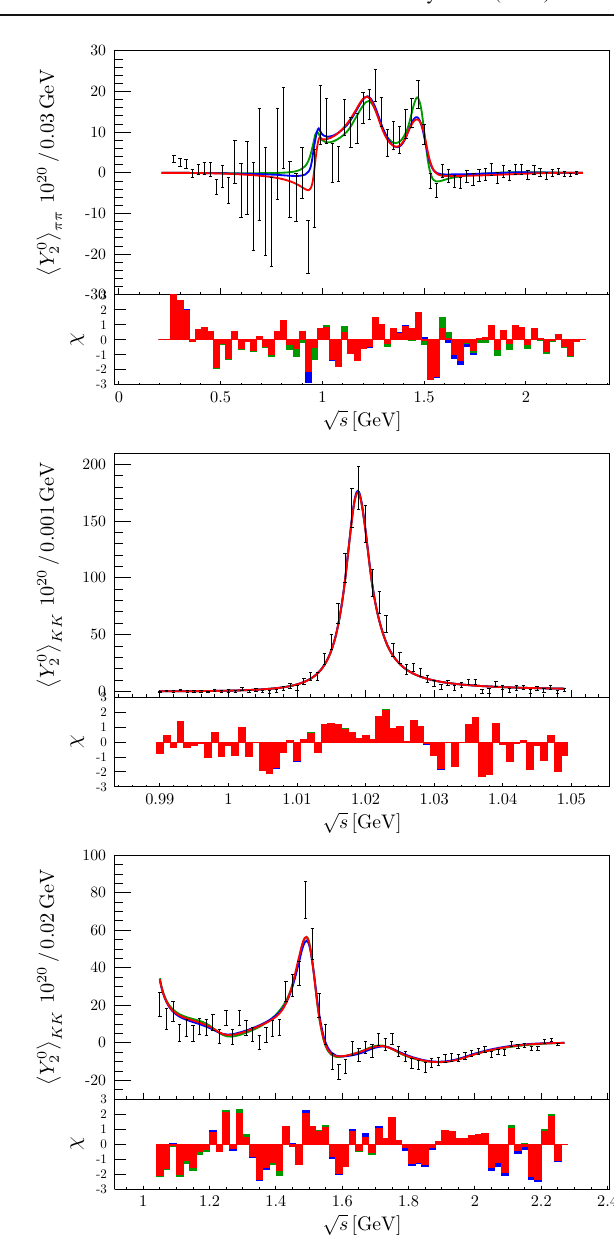
(cid:3) (cid:2) (cid:3) (cid:2) Y 0 Y 0 and for the decay ¯ B 0 s → 0 2